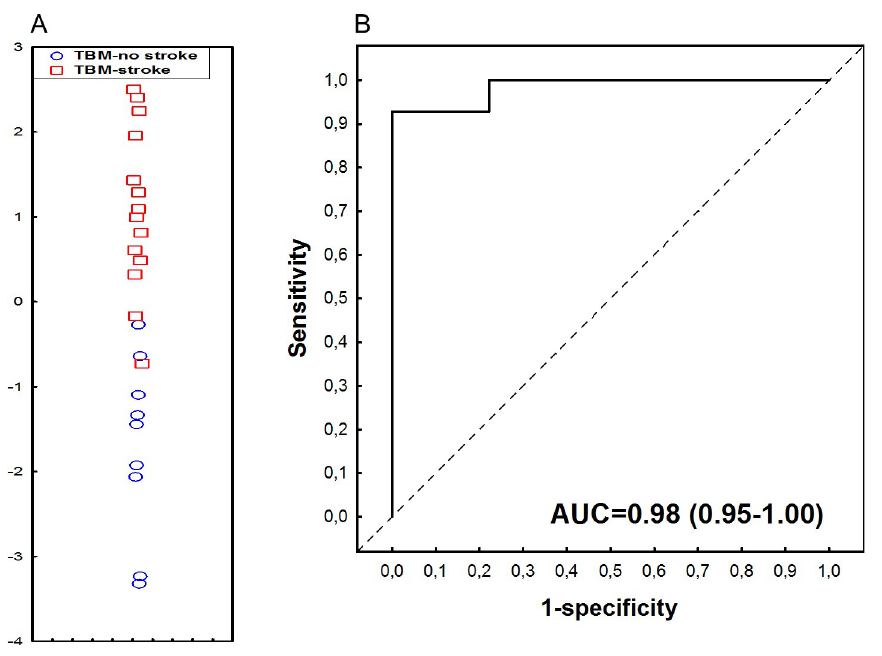
Fig 4. Accuracy of the 4-marker CSF host protein biosignature (VEGF-A, complement component 5a, complement factor 1 and BDNF) in indicating stroke amongst children with TBM. (A) Scatter plot depicting the separation of children as TBM with stroke/no-stroke using the 4-marker biosignature. (B) ROC curve depicting the performance of the 4-marker biosignature. Red squares: TBM-related stroke. Blue circles: TBM, no stroke.